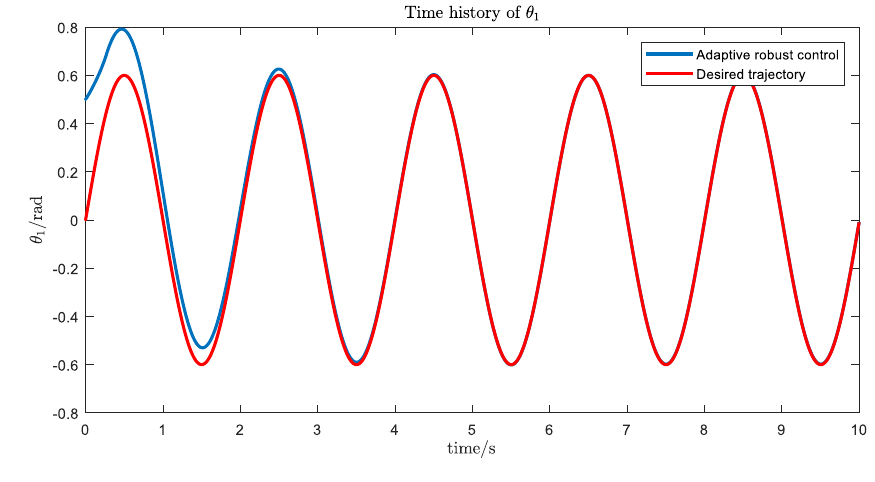
Figure 16. The trajectory tracking of joint 1.